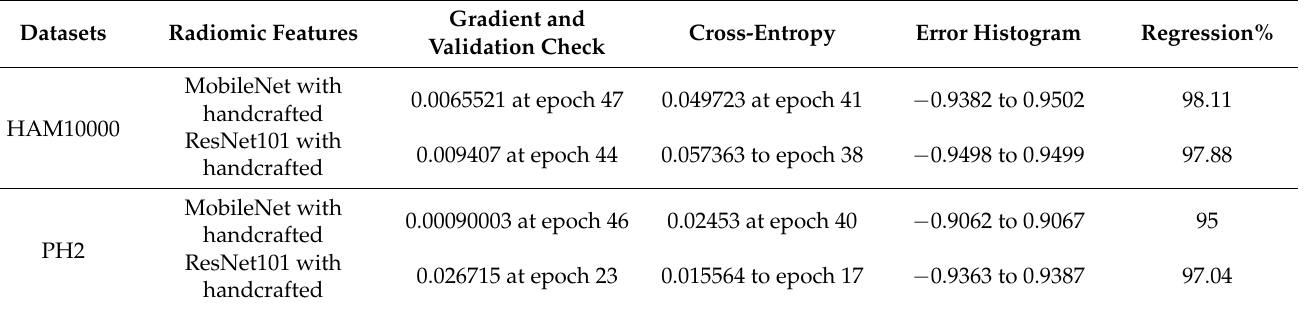
Table 10. ANN performance measures for classification of the HAM10000 and PH2 datasets for skin